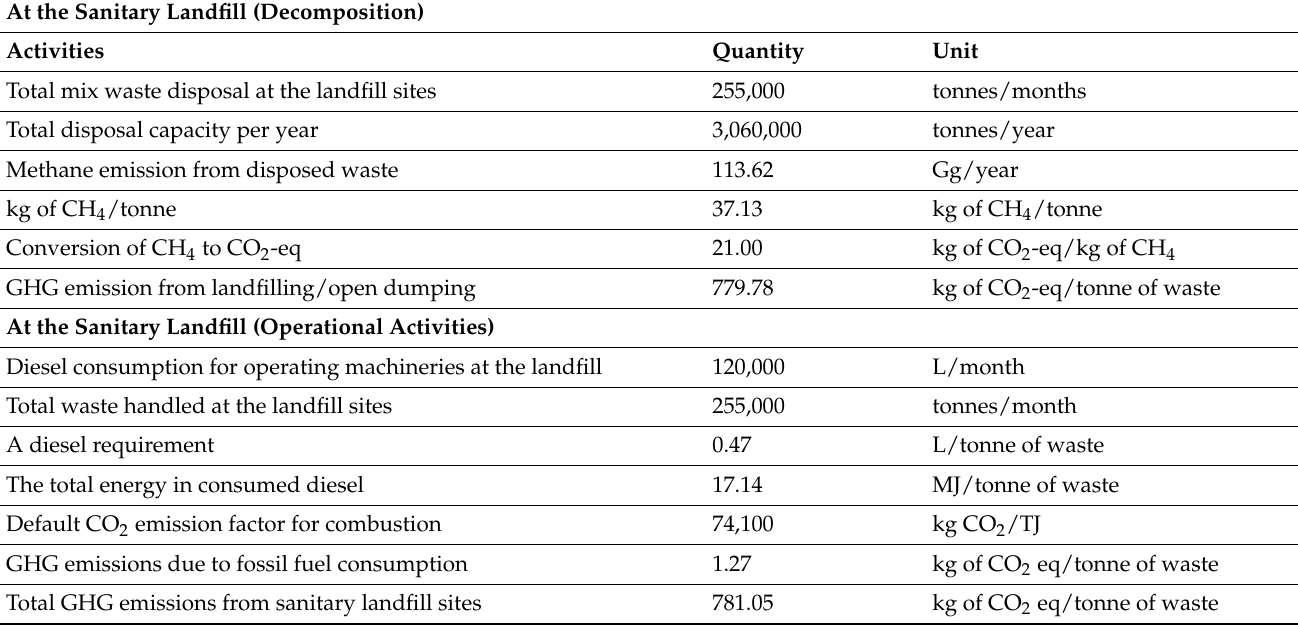
Table 3. Estimates of GHG emissions from landfill activities in Ho Chi Minh